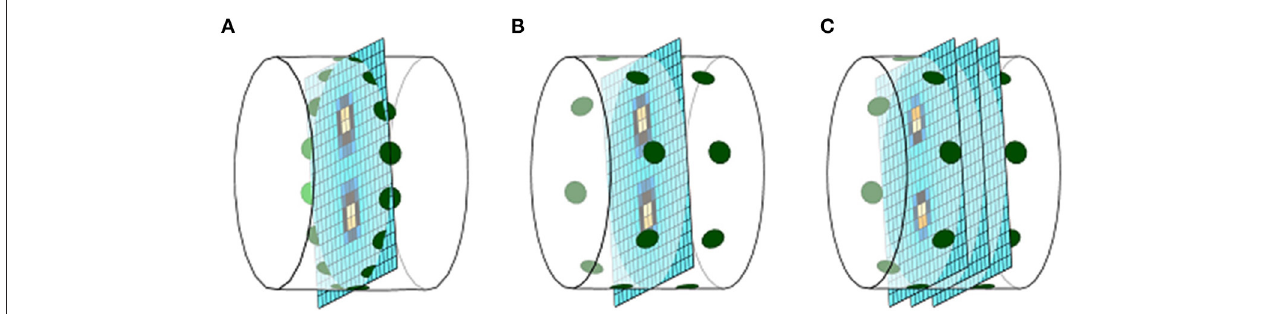
FIGURE 2 | Illustration of EIT reconstruction in 2D and 3D (left to right): Cranial is towards the left of the image and caudal to the right. (A) A single electrode and image plane. (B) A single image plane with multiple electrode planes. (C) Multiple electrode and image planes.